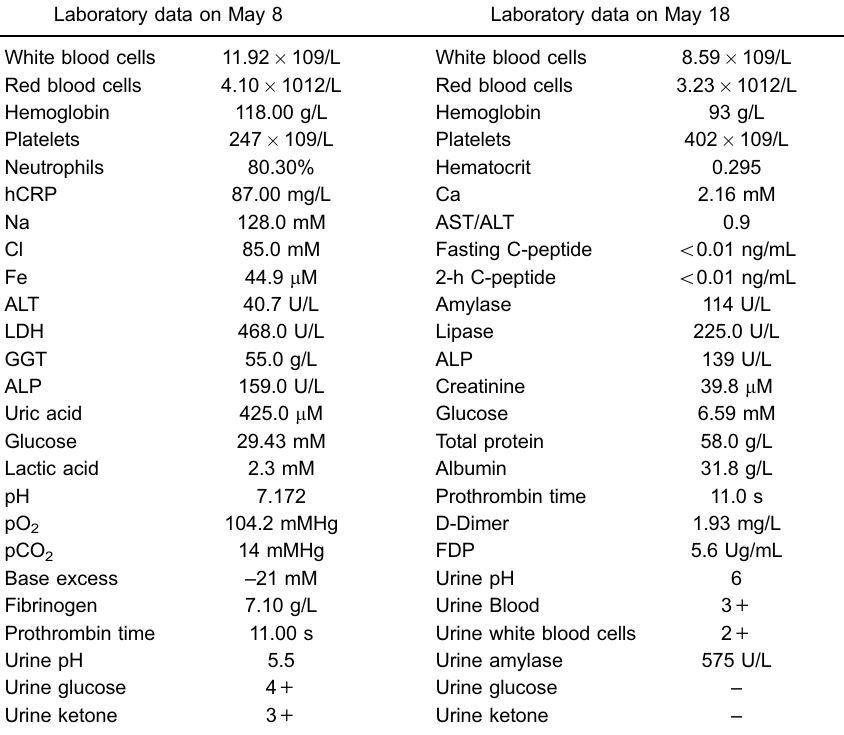
Table 1. Laboratory data of Patient